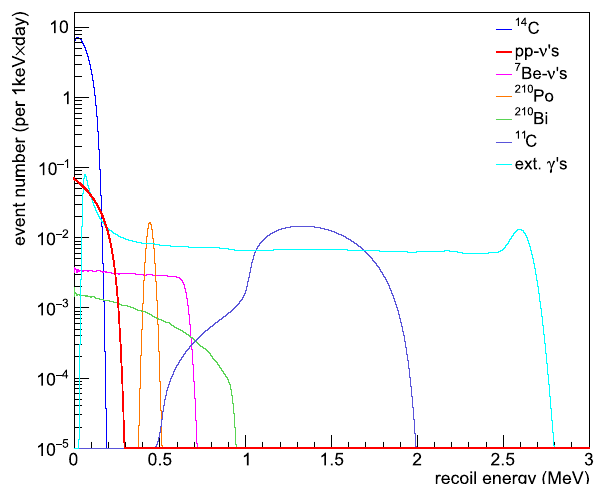
Fig. 3 Energy spectra for all contributions explicitly regarded in the analysis, i.e., solar pp and 7 Be neutrino events and 14 C, 210 Po, 210 Bi and 11 C background events. Rate normalizations correspond to a fidu- cial mass of 9.3 tons (Sect. 4.2). External backgrounds are not shown. The spectral shapes already take into account an energy resolution that corresponds to 1500 p.e./MeV